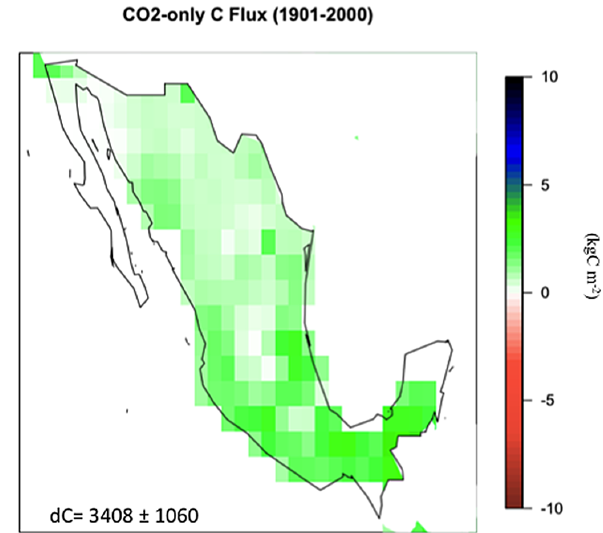
Figure 6. Total change in land C during 1901–2000 (kgCm − 2 ) . A positive sign indicates C gain. dC is total change in stored C (TgC).